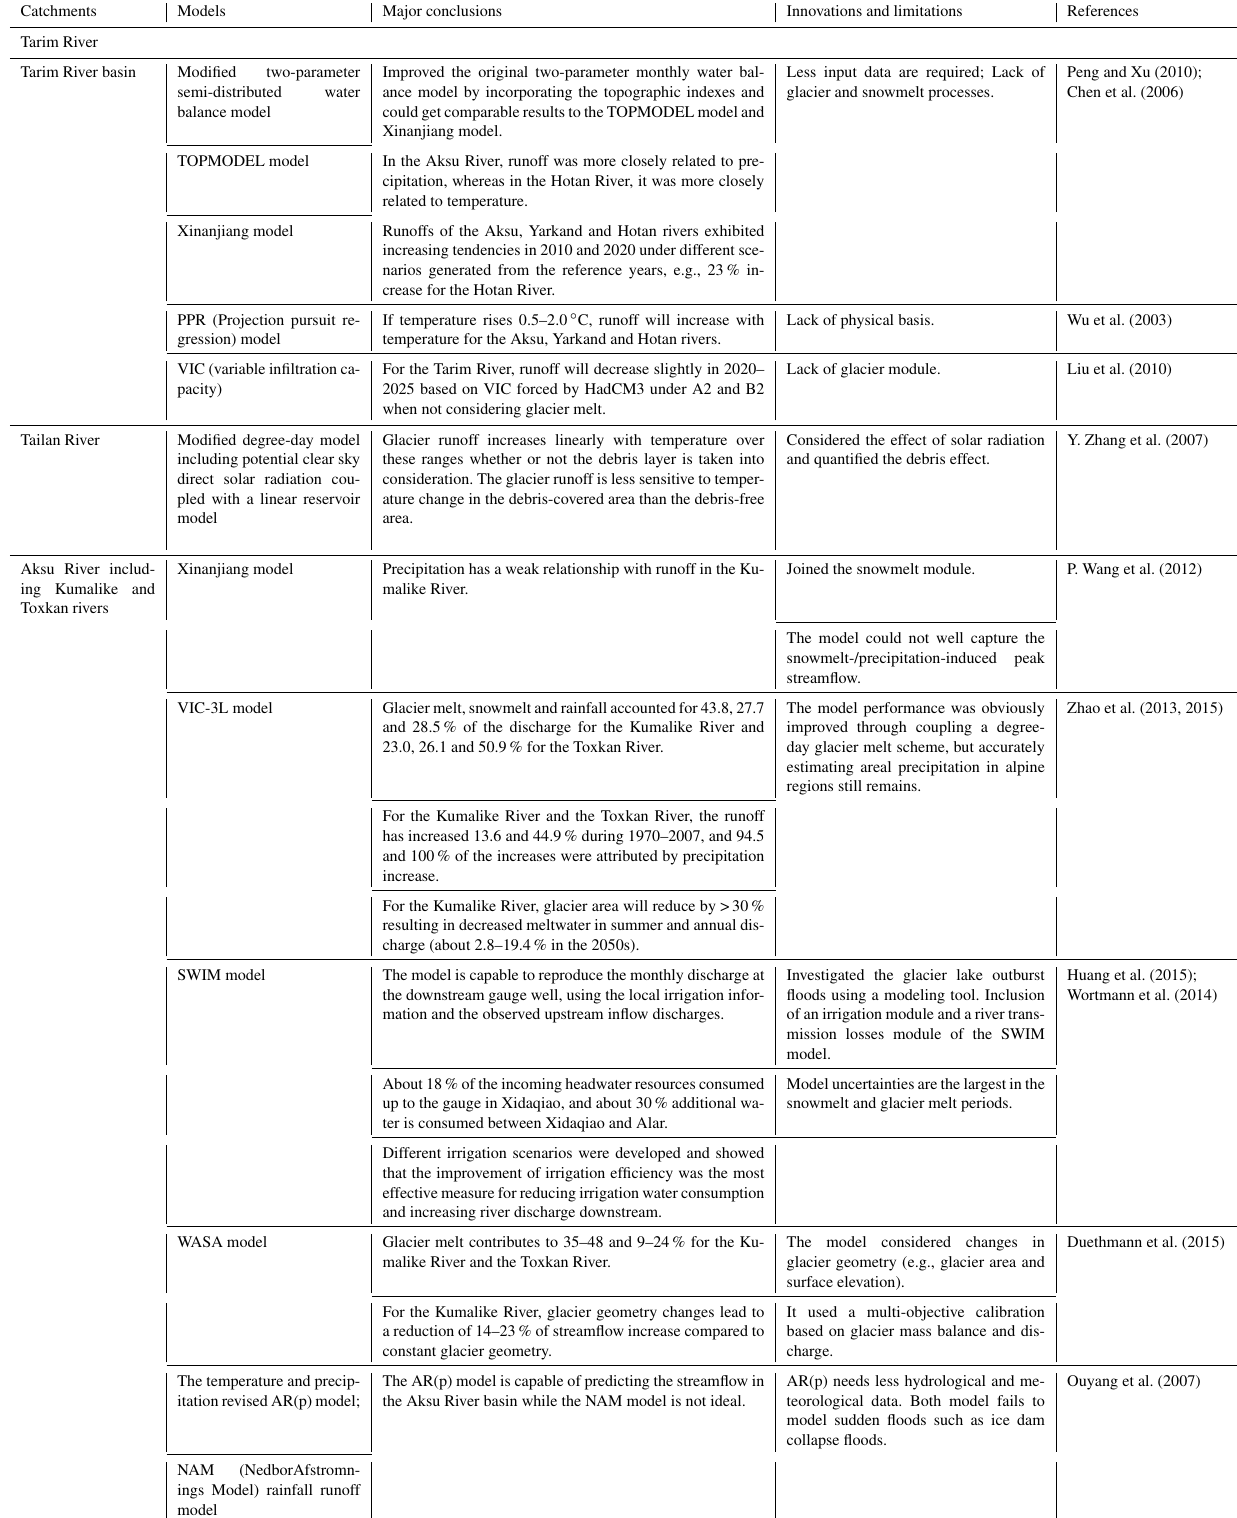
Table 2. Summary of hydrological modeling in glacierized central Asian